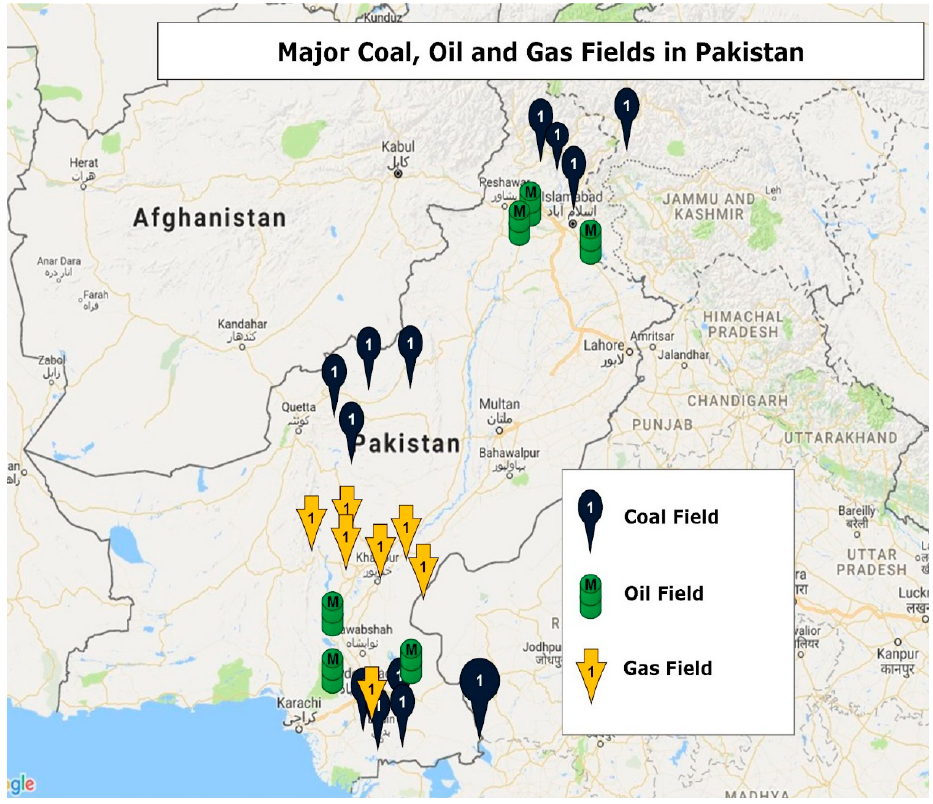
Figure 3. Map of the major coal, oil and natural gas production sites in Pakistan.